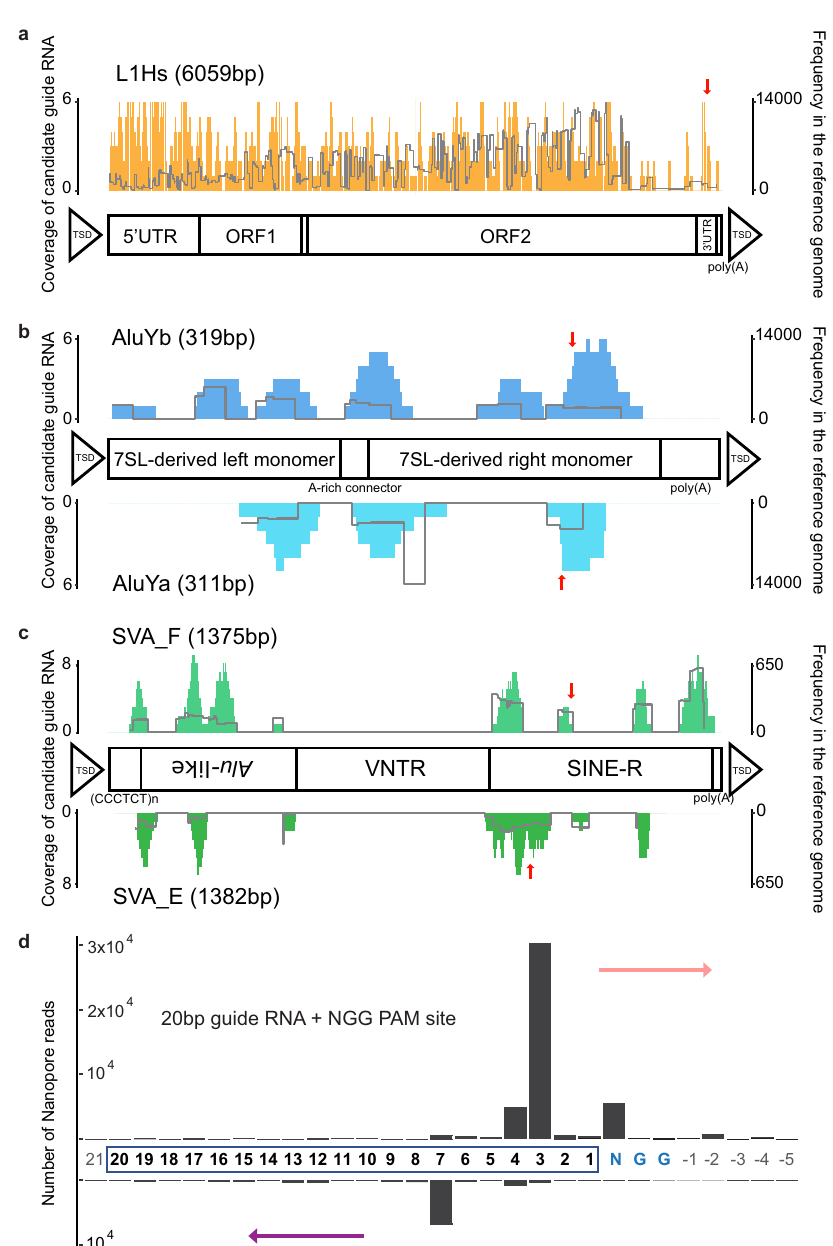
Fig. 2 Guide RNA design for MEIs and guide RNA cleavage-site distribution. a Distributions of candidate guide RNAs (left Y -axis and the histogram) in the L1Hs consensus sequence and structure information. The right Y -axis and the line indicate frequency of corresponding candidates in the reference genome sequence. b Upper panel shows the distribution for Alu Yb and the lower panel for Alu Ya. c Upper panel shows the distribution for SVA_F and the lower panel for SVA_E. Red arrows in a – c indicate where the selected guide is. d Cleavage-site distribution of all guide RNAs in this project. The x -axis indicates the position where the read ends or begins, with the number depicting the base distance from the PAM site (NGG). The PAM site (NGG) is colored blue and guide RNA bases are highlighted by a rectangle. Bases outside of the guide RNA or the PAM site are colored gray. The y -axis is the number of nanopore reads counted. The upper bar represents reads with forward strand sequencing outward from the 3 ′ end of the guide RNA (rose arrow), and the lower bar represents reads with reverse strand sequencing outward from the 5 ′ end of the guide RNA (purple SVA_E (Table 1). When an L1Hs enrichment experiment was reaches an average of 44% of nanopore sequencing reads with sequenced on a MinION fl ow cell, the on-target rate was target MEI signal from these seven fl ow cell runs. approximately 35.0% (FAL11389) and 23.3% for a pooled MEI run (FAO84736). Compared to earlier studies (2.09% in Flongle and 4.61% in MinION) 47 , these results show substantially improved enrichment, with a 1-fold to 25-fold increase relative to the Flongle fl ow cell, and over 5-fold enrichment relative to the MinION fl ow cell. These enrichment increases are likely due to the frequency of the targets in the genome. Overall, our approach